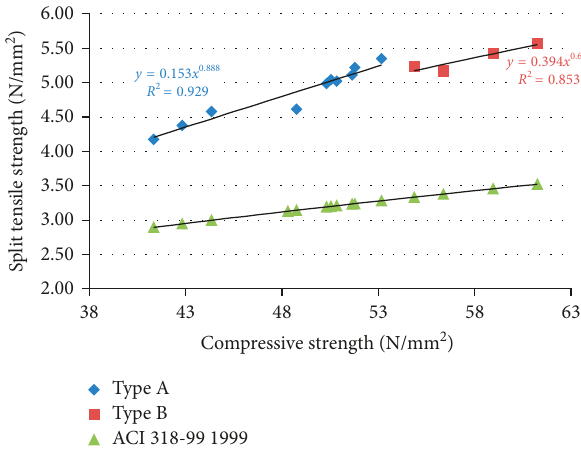
Figure 6: Relationship between split tensile strength and compressive strength of concrete mixes at 28